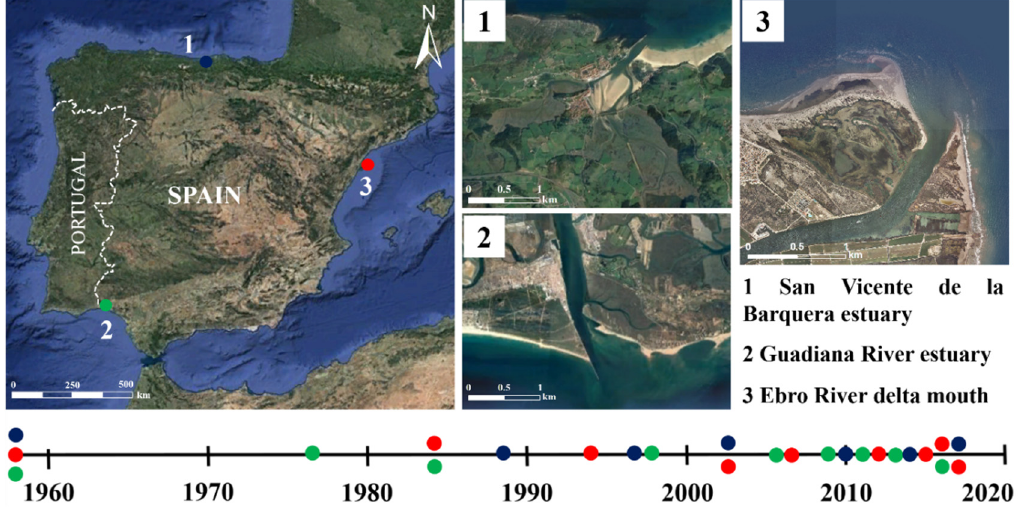
Figure 1. Location of the study areas along the Iberian coast (central), with a closer look at the sites ( 1 – 3 ) and detail on the sequence of aerial orthophotos available for the study period (bottom). The legend of the dots matches colours in the central image: ( 1 ) SVB: blue, ( 2 ) GUA: green and ( 3 ) EBR: red.